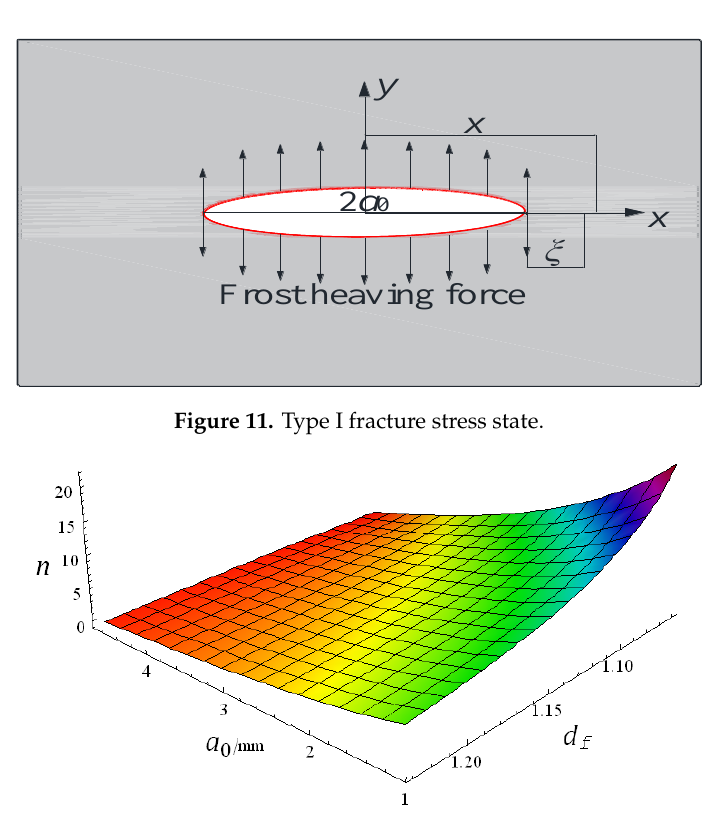
Figure 12. The relations among fracture construction times, fractal dimension, and fracture size.